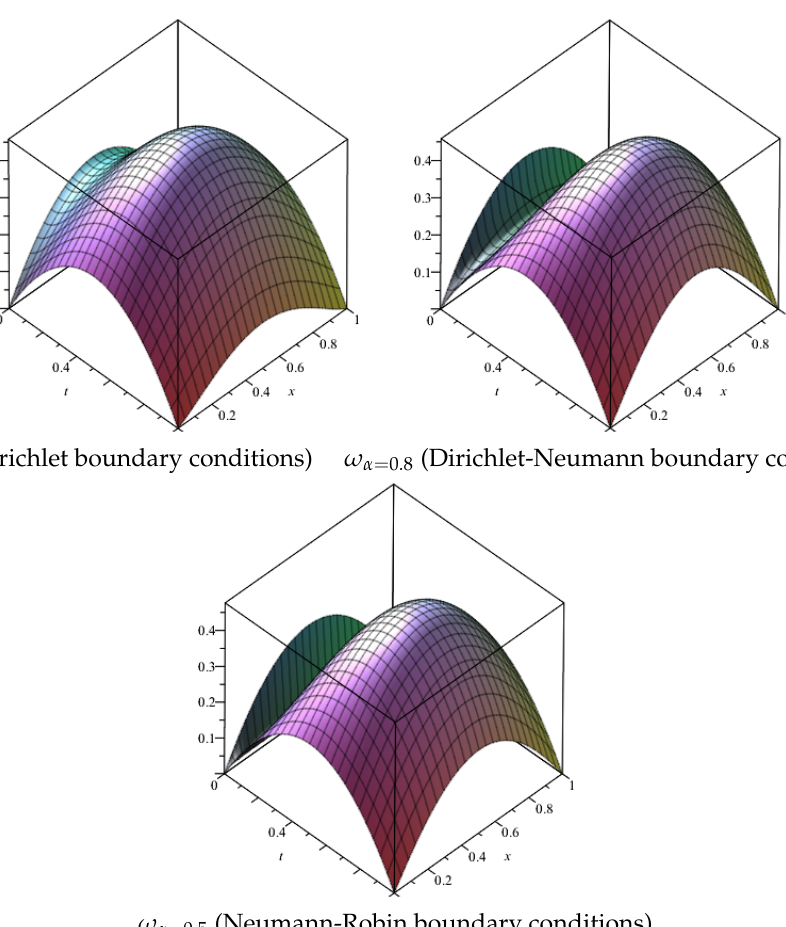
Figure 7. Graphs of solutions for order α = 1,0.8, and